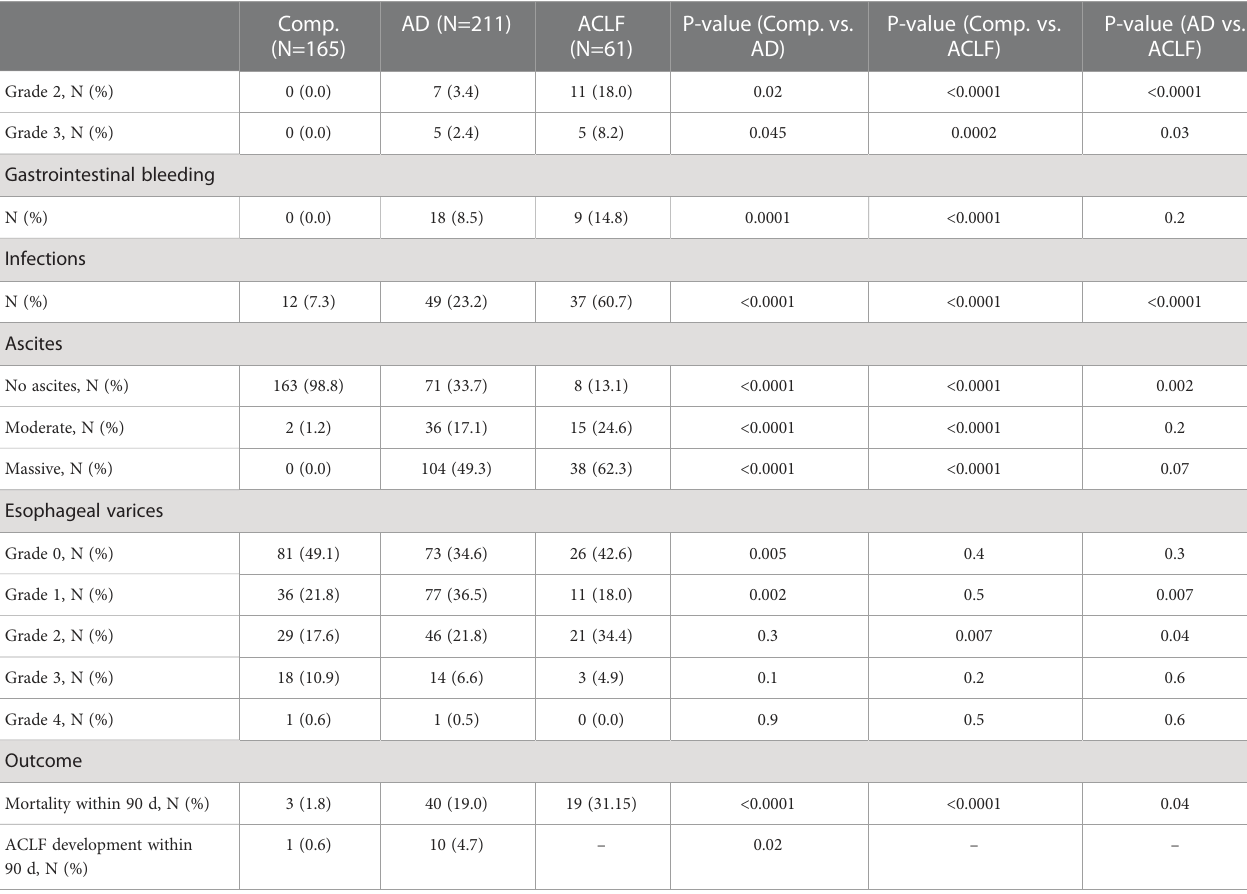
in Figure 3A, FT 3 concentration below the lower limit of normal was signi fi cantly associated with the risk of death within 90 days.